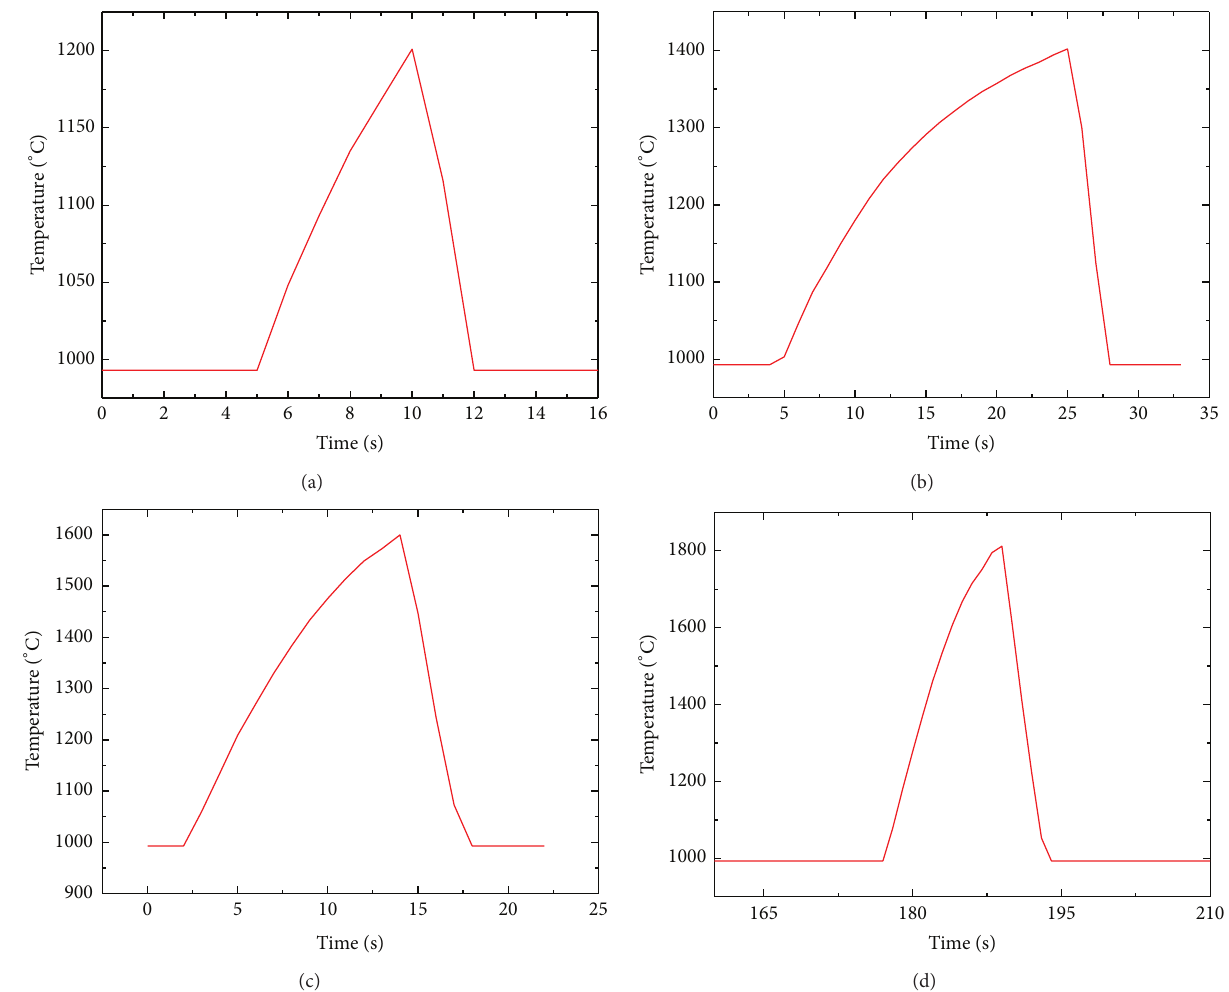
Figure 2: Temperature curve of a single thermal shock: (a) 1200 ∘ C; (b) 1400 ∘ C; (c) 1600 ∘ C; (d) 1800 ∘